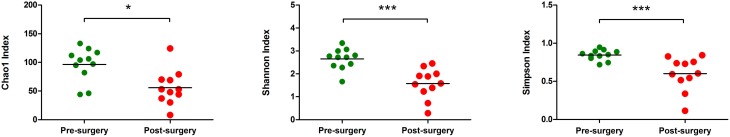
Alpha diversity metrics (Chao 1, Shannon and Simpson indices) of OTU-level fecal bacterial communities from obese individuals; each point represents a sample. Paired Student's t-test was performed to compare alpha diversity estimates before and after bilio-intestinal bypass. Asterisks indicate statistical significance (*P < 0.05; ***P < 0.001).